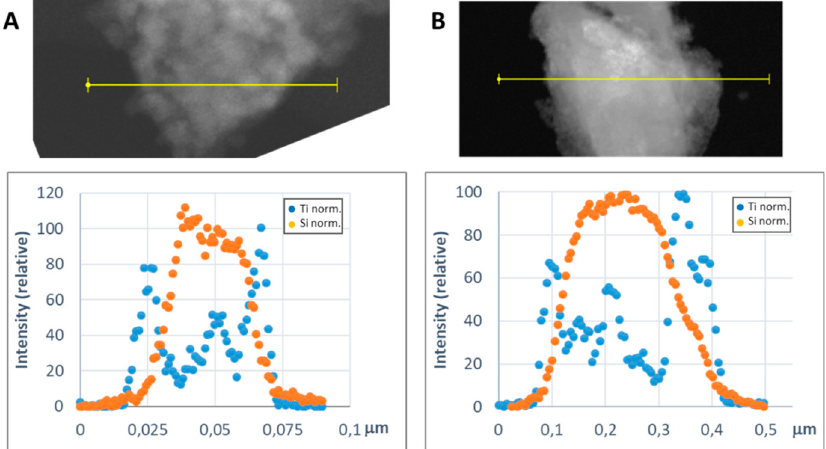
Figure 8. Representative line scans of the M x O m @SiC core–shell NPs (lab synthesis) (STEM-EDX, line scan tool): ( A ) TiO 2 @SiC (50 nm) and ( B ) TiO 2 @SiC (500 nm). The upper part corresponds to the direct